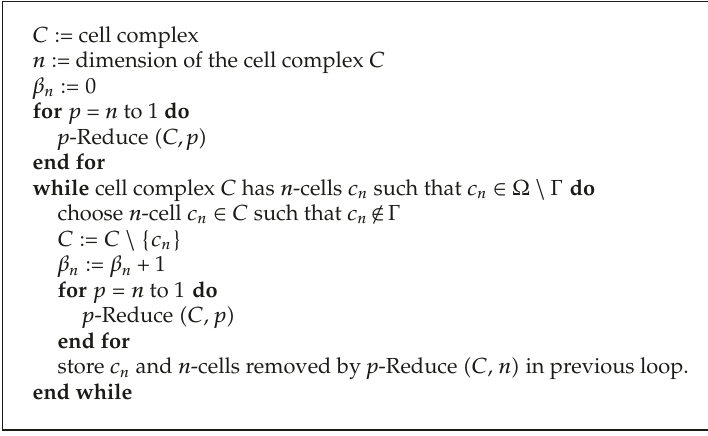
Algorithm 2: Reduce-Omit.